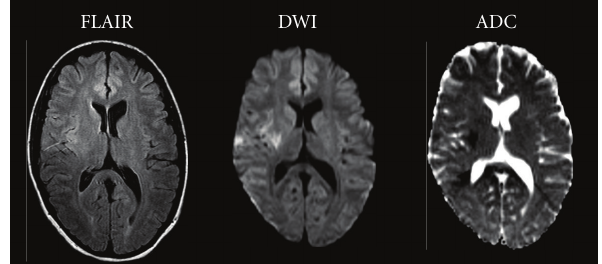
Figure 10: Case 4: acute MRI with FLAIR, DWI and ADC showing an established infarction in the right basal ganglia that was not detected by the CTP examination.